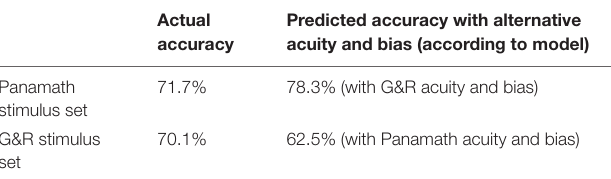
TABLE 6 | Alternative strategy